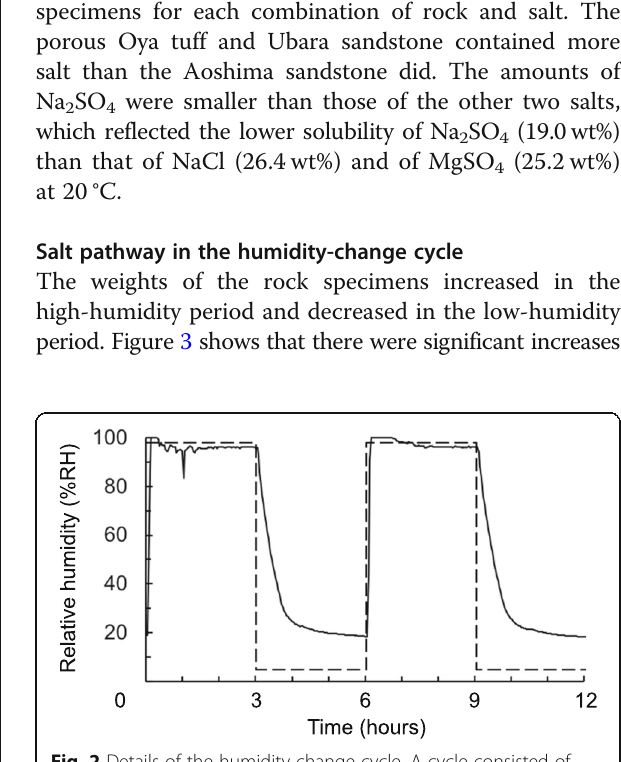
Fig. 2 Details of the humidity-change cycle. A cycle consisted of high- and low-humidity periods lasting 6 h in total. The solid line represents the relative humidity measured at 5 min intervals. The dashed line represents the setting of the ambient